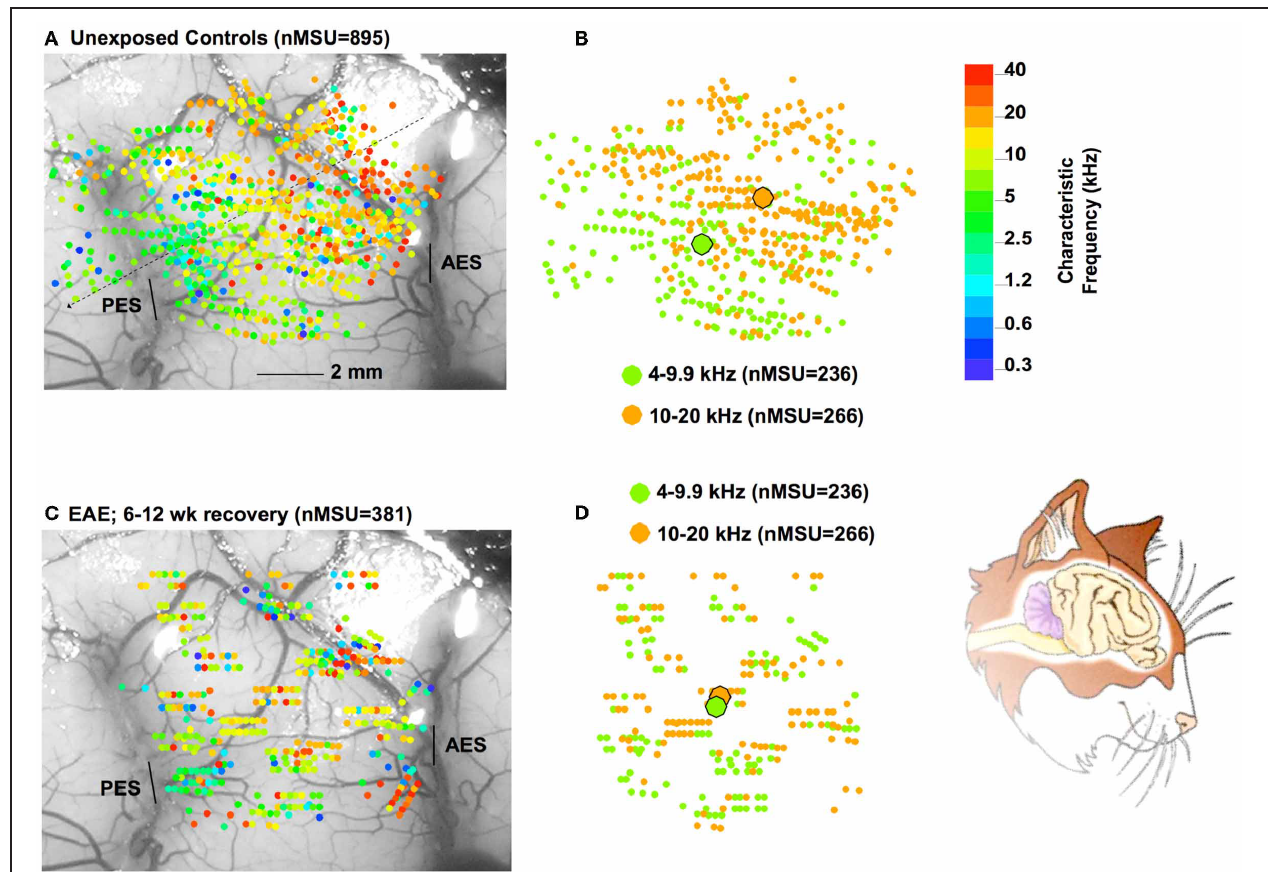
circles) for these two frequency regions. In part (C) results are plotted for 381 recording sites for cats exposed to 68dB SPL for 6 weeks followed by 6–12 weeks of recovery in quiet. (D) As the data for the 4–9.9 and 10–20kHz show, the centers of gravity now overlap, indicating a distorted tonotopic map. The cartoon on the bottom right is similarly oriented as panels (A) and (C)